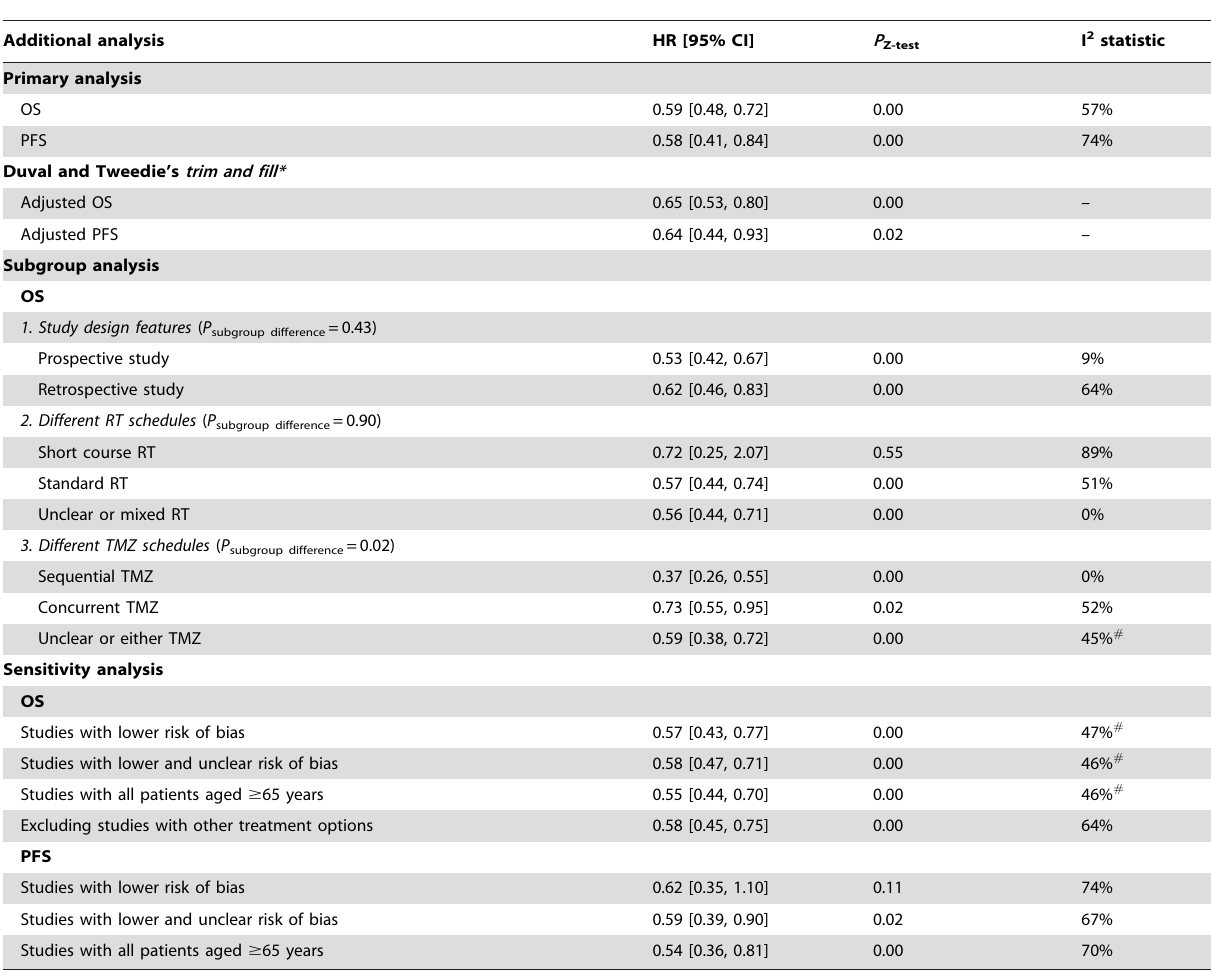
Table 2. The results of additional